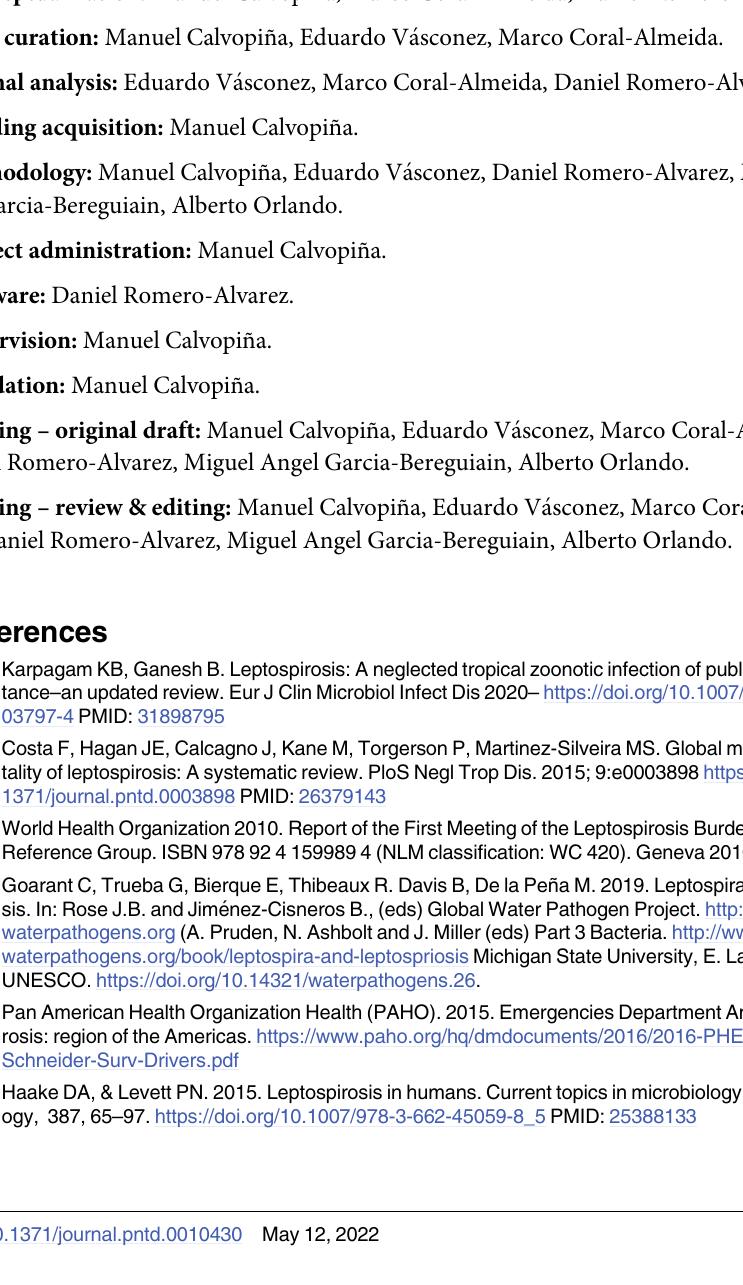
S1 Table. Curated database of hospitalized leptospirosis cases in Ecuador (2000–2020) derived from the National Institute of Statistics and Census (INEC, Spanish)